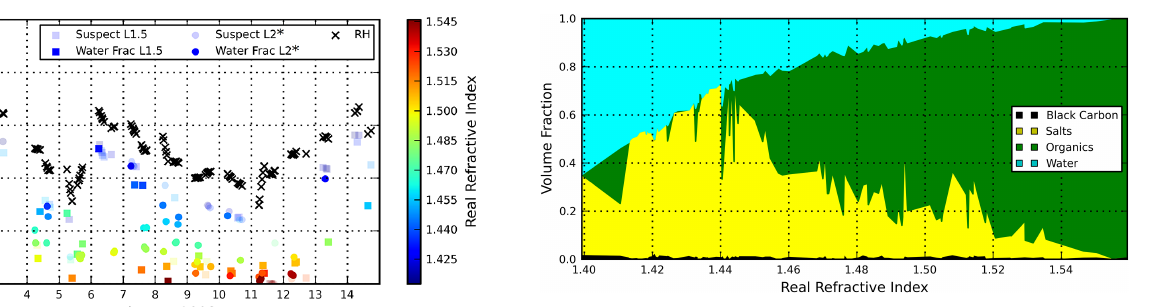
Figure 12. Volume fraction of the modeled aerosol components as a function of the optimized real refractive index during May 2008. Here, the sum of (ammonium) sulfates and ammonium nitrate has been taken into inorganic “salts”, because their ratio is held constant throughout the